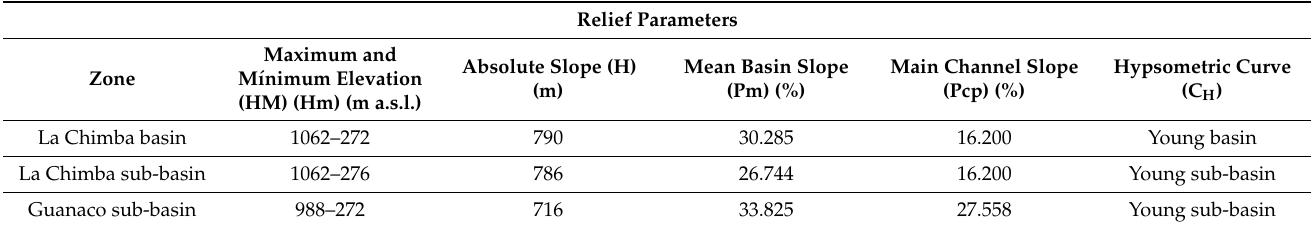
Table 10. Relief parameters, whose value is related to its meaning. Relief